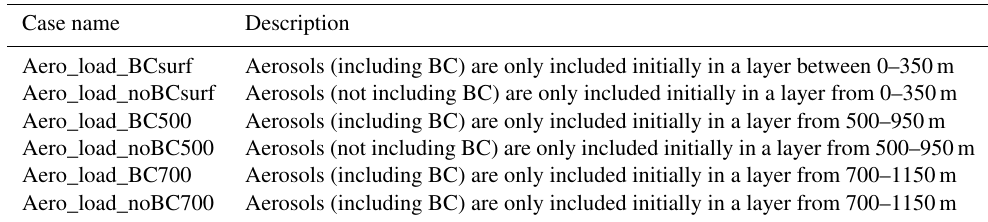
Table 3. Table detailing the outline of each of the six simulations for the first case study (Case Aero_load).